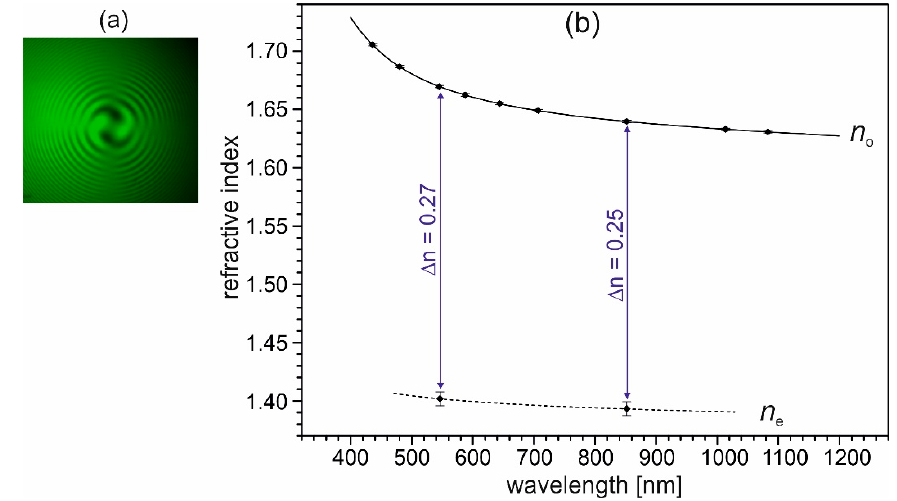
Figure 9. ( a ) Interference figure of a (001) plate of (2-AMP) 3 (H 3 BO 3 ) 2 , taken with a polarizing microscope in conoscopic illumination with crossed polarizers, using monochromatic (546.7 nm) light and a quarter-wave plate between the crystal and the analyzer. The spirals in the interference figure indicate a levo-rotatory optical activity of the used crystal of (2-AMP) 3 (H 3 BO 3 ) 2 . Note, that dextro-rotatory crystals occur with equal probability during crystal growth. ( b ) Principal refractive indices n o and n e of trigonal (2-AMP) 3 (H 3 BO 3 ) 2 and their wavelength dispersion. Measured data are indicated by dots (with given error bars), the line for n o indicates the fitting curve with a Sellmeier-type equation (see text). The dashed line connecting the two data points of n e is a guide to the eye.